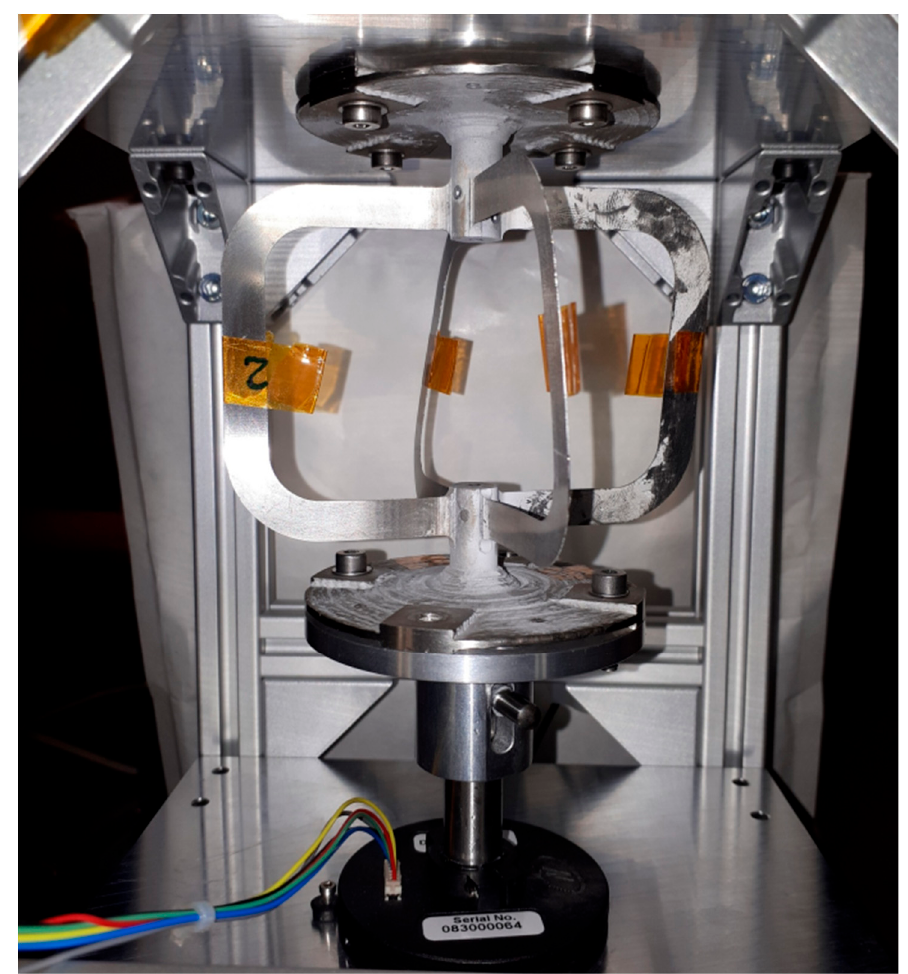
Figure 30. Flexure hinge integrated in the lifetime test bench.